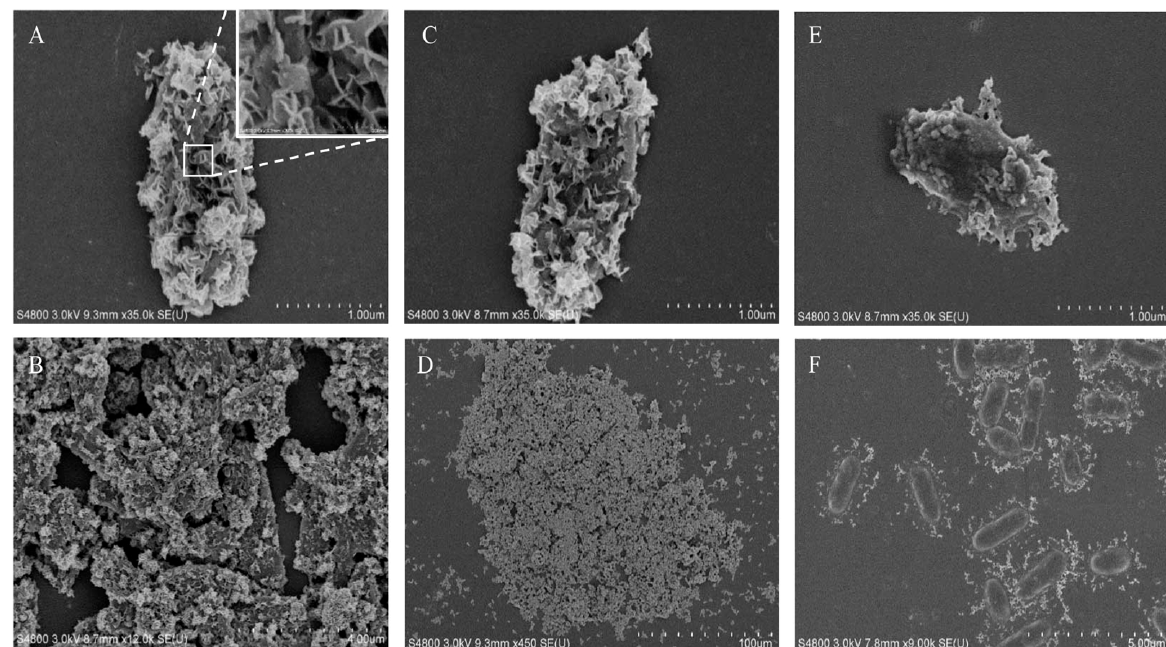
Figure 4. Scanning electron microscope (SEM) analysis of precipitates obtained in magnetic MIP. SEM analysis was applied on precipitates from magnetic MIP with 8-mM ( A , B ), 0.8-mM ( C , D ), 0.16-mM ( E ), and 0.08-mM ( F ) FeCl 2 .